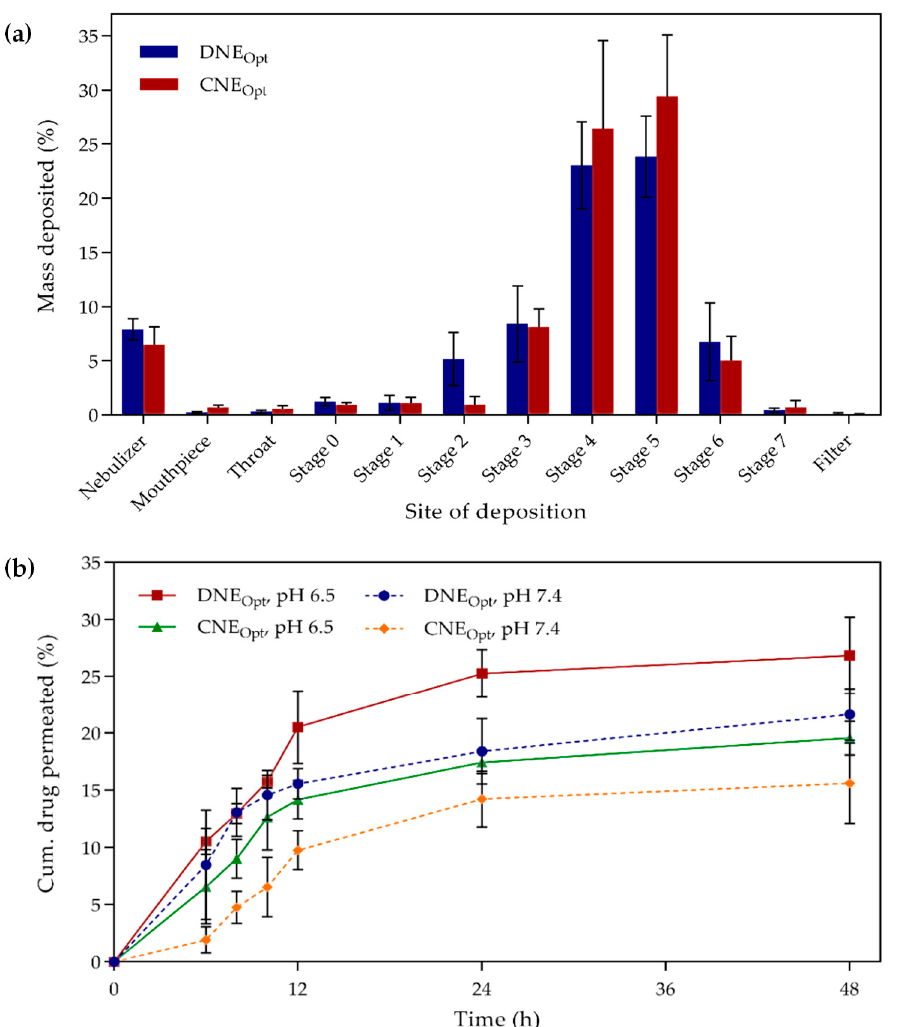
Figure 5. In vitro studies of ( a ) drug deposition using eight-stage Anderson cascade impactor and ( b ) drug release using the dialysis membrane diffusion method in simulated lung fluid (SLF) solution of pH 6.5 and 7.4 at a constant temperature of 37 ± 1 °C. Error bars denote standard deviation ( n = 3).